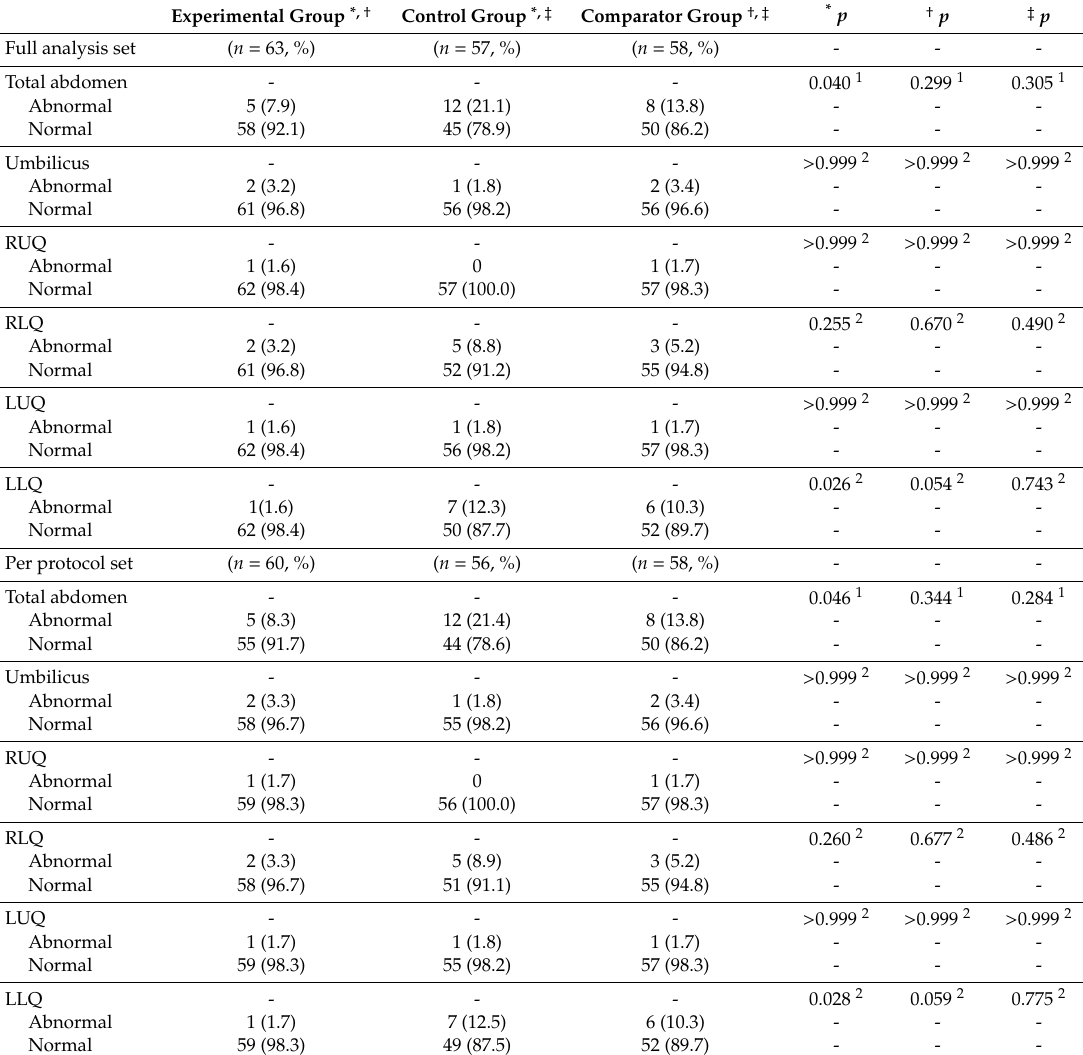
Table 2. Incidence rate of abdominal adhesion formation assessed by visceral slide test at 4 weeks after